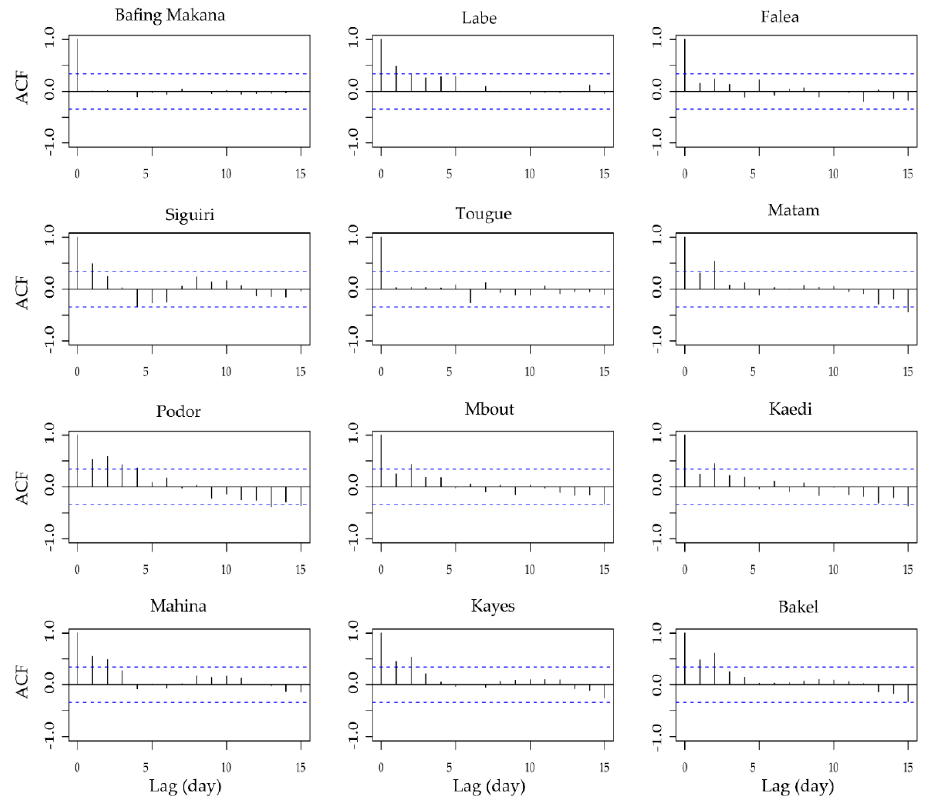
Figure 3. Autocorrelation (ACF) of the annual evapotranspiration of a few stations (the blue dotted line represents the 95% confidence interval).